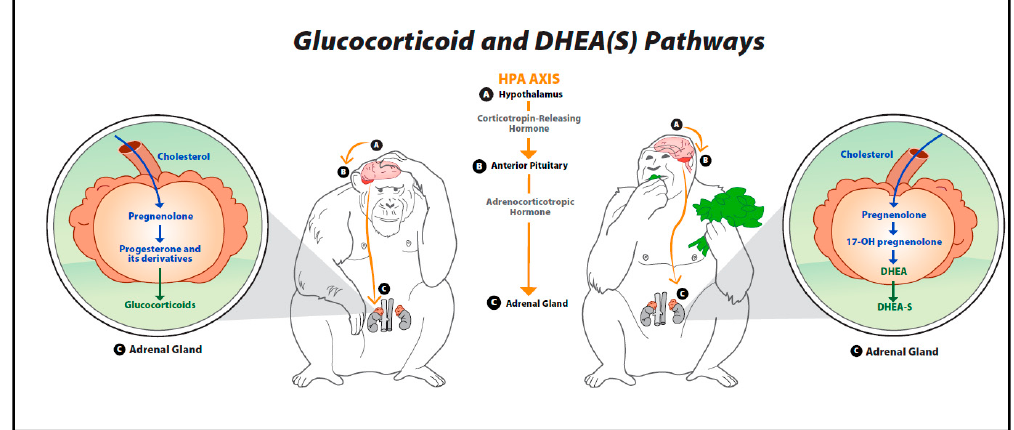
Figure 1. Glucocorticoid and dehydroepiandrosterone pathways.